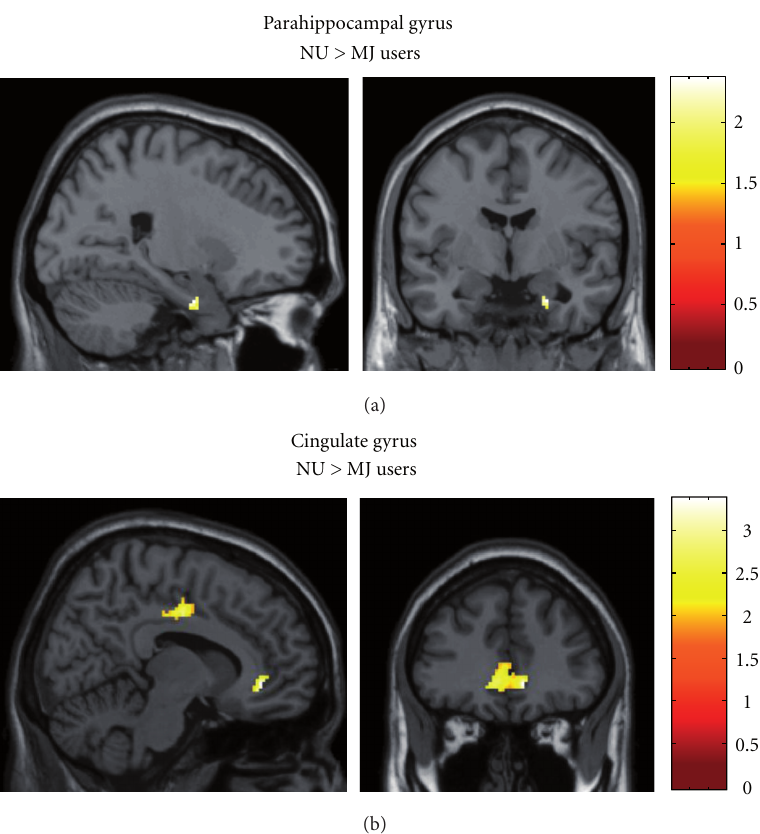
F 4: �epresentative S�M images depicting signi�cant activation for the �etrieval-Motor �ontrol contrast for NU MJ contrast. (a) NU displayed greater activation in the right parahippocampal gyrus relative to the MJ group. (b) NU displayed greater activation in the bilateral anterior cingulate gyrus and bilateral midcingulate gyrus relative to the MJ group. For the MJ NU contrast, the MJ group showed no regions > of greater BOLD activation relative to NU group. All images are in neurological orientation, that is, le = le and right = right; the color bar at the right re�ects the suprathreshold value of the S�M ( ) statistic for the > 𝑡𝑡